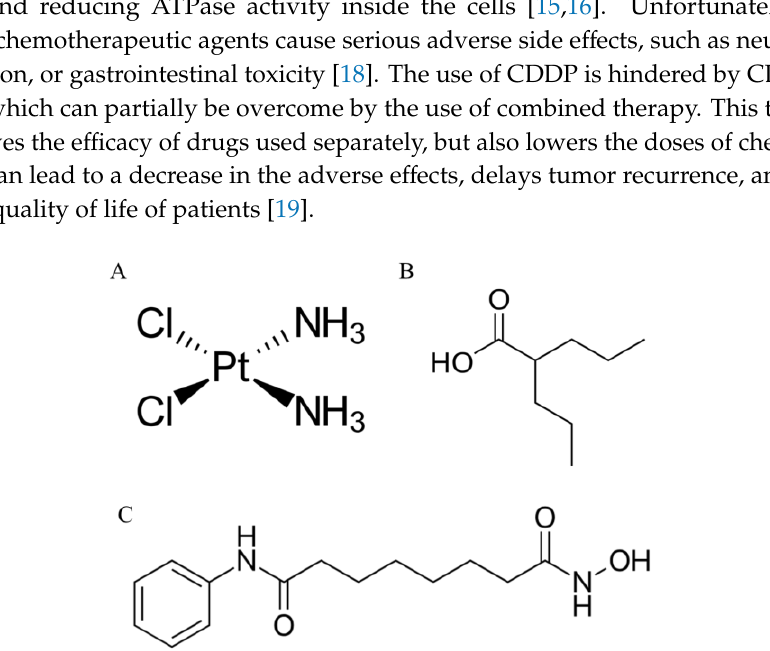
Figure 1. Chemical structures of ( A ) cisplatin (cis-diamminedichloroplatinum (II), cisplatin (CDDP)); ( B ) valproic acid (VPA) and ( C ) vorinostat (suberoylanilide hydroxamic acid, SAHA).